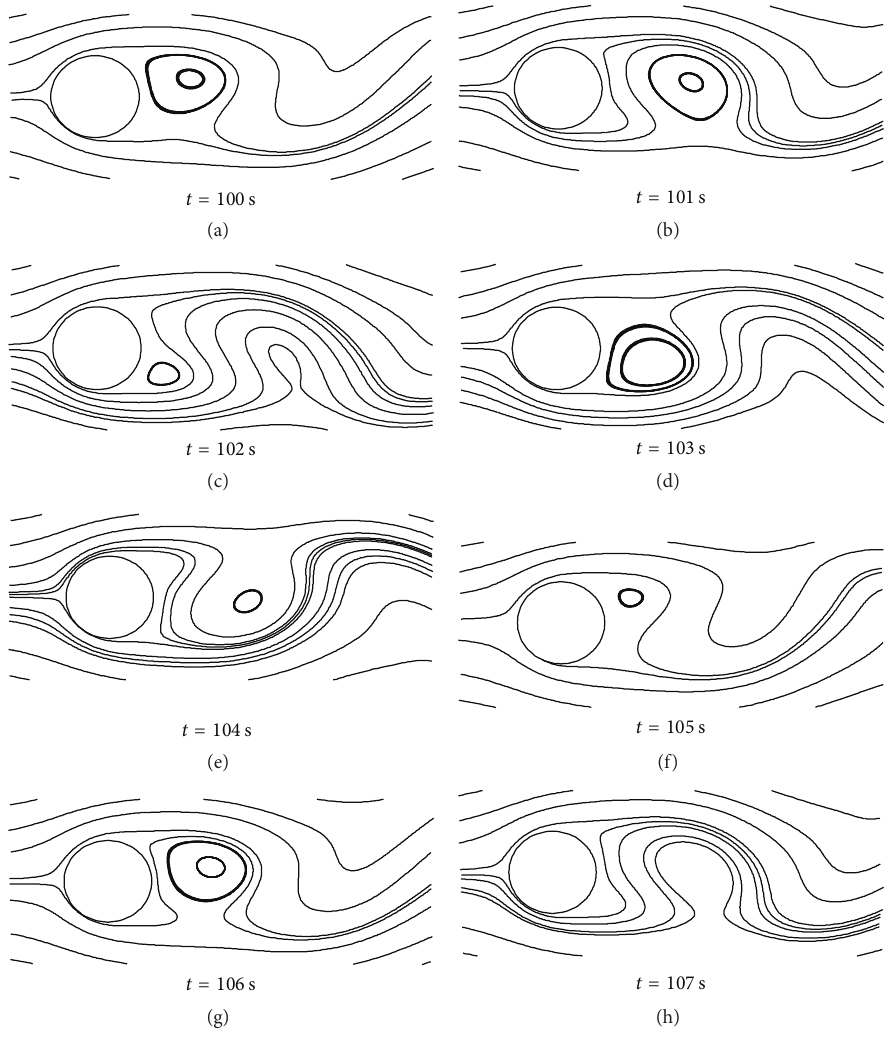
Figure 9: Time-dependent streamline contours for Re = 100